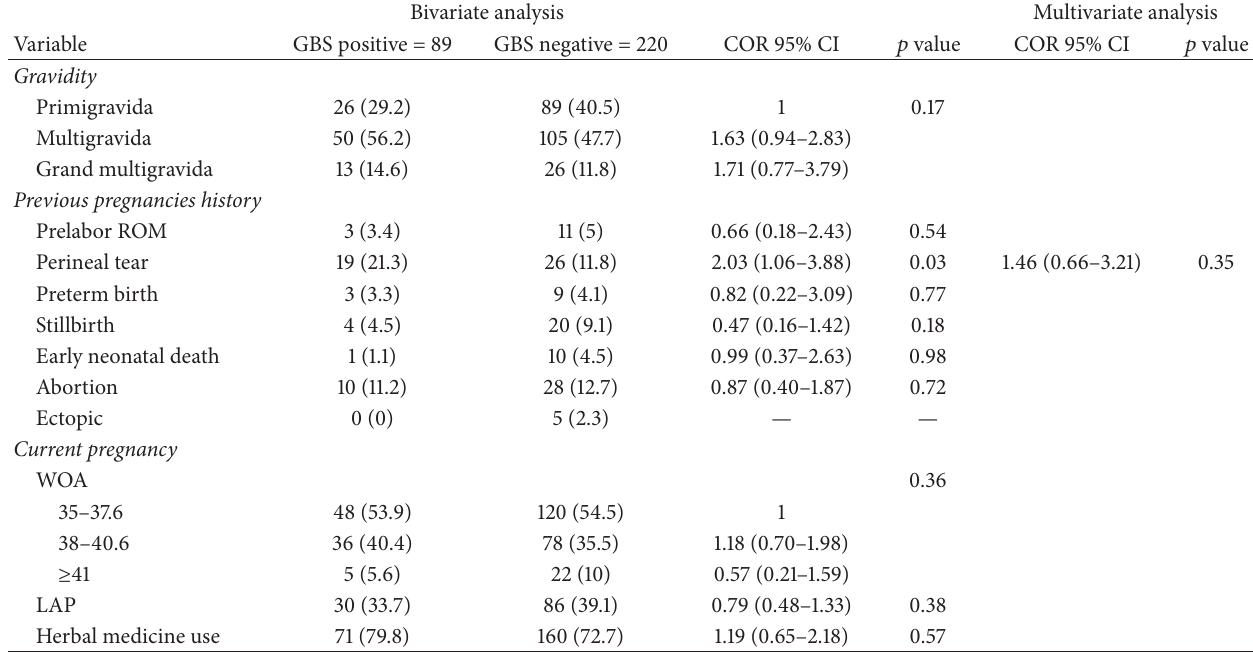
Table 4: Association between GBS colonization status and potential obstetric risk factors. Bivariate analysis Multivariate